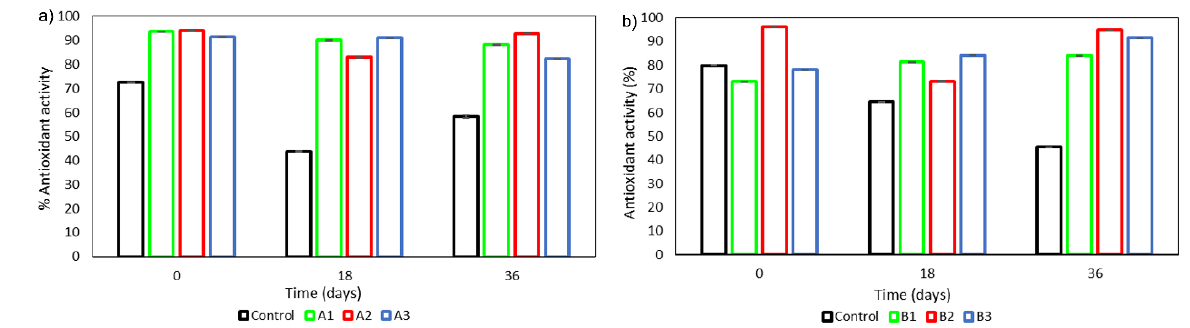
Figure 7. Antioxidant activity of cosmetic formulations after zero, 18, and 36 days: ( a ) formulation A with the three incorporated extracts (A1, A2, and A3) and ( b ) formulation B with the three extracts incorporated (B1, B2, and B3).